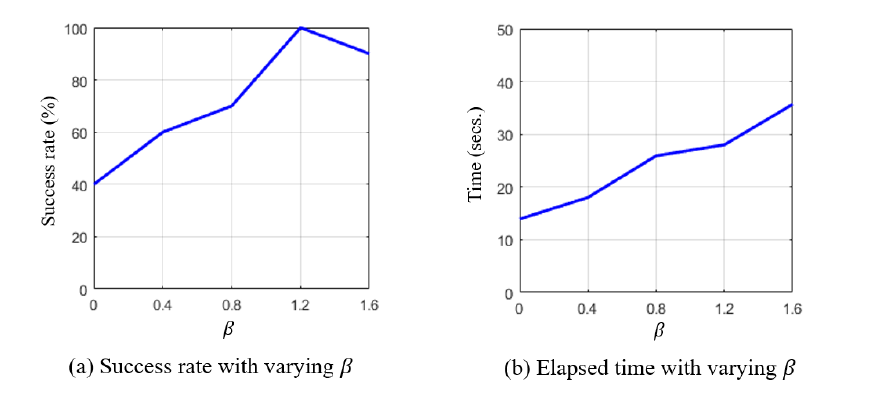
Figure 10. In this graph, the performance of the proposed algorithm U safe for double integrator is presented for the scenario when 20 passive agents are present. ( a ) show the success rate for selected values of β . ( b ) show the elapsed time for different values of β . The robot takes comparatively longer time to reach goal when the larger value for β is set, as robot take the safer path to the goal rather than a direct path to it. Results show that robot reaches the goal with relatively high success rate when β = 1.2 is selected, while the elapsed time is comparatively